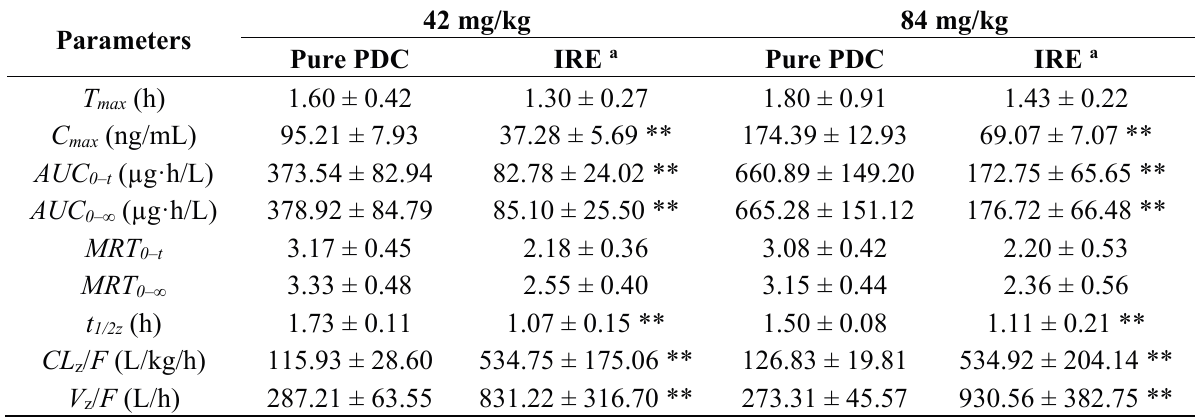
Table 4. Pharmacokinetic parameters of PDC in rat plasma after oral administration of pure PDC or the IRE (42 and 84 mg/kg) ( n =